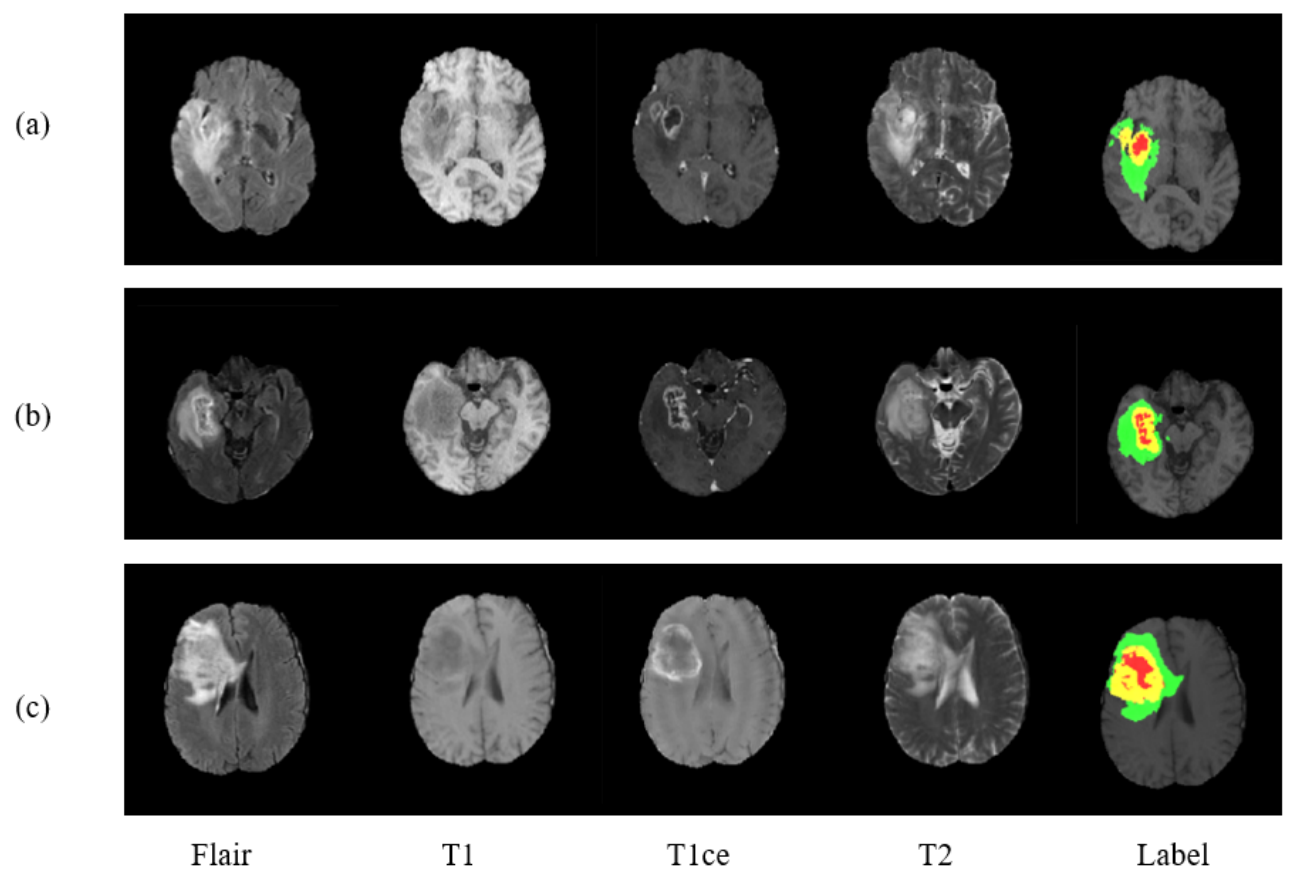
Figure 1. Presenting three MRI cases ( a – c ) of brain tumor with four modalities and a label plots. From left to right are Flair, T1, T1ce, T2, and Label. In ground truth image each color represents different tumor class. Red for necrosis and non-enhancing, green for edema, and yellow for enhancing